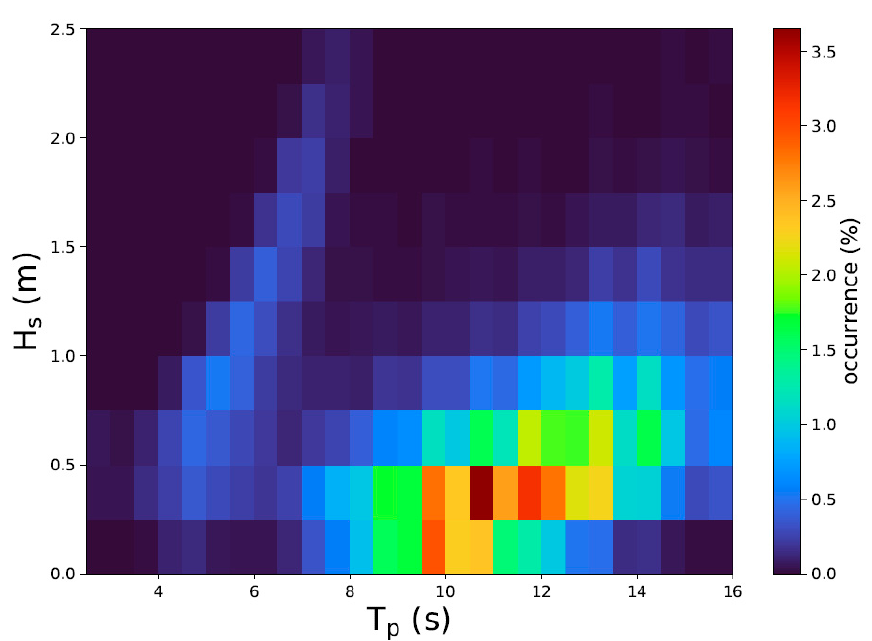
Figure 11. Mean distribution of wave events for a range of significant wave heights H s and peak periods T p , at the western end of the line offshore from the harbour breakwater during the ten-year period from 2006 to 2015. The color bar shows the occurrence of waves events in percentages.